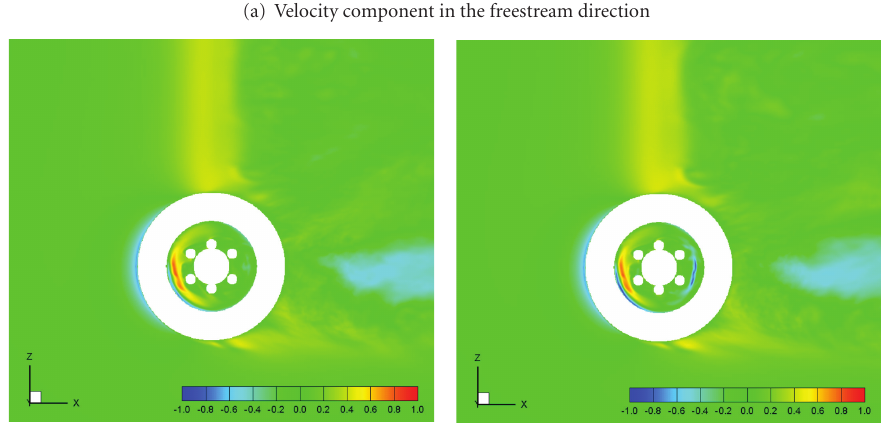
and NO TEAR are almost identical, whereas the values of NO TEAR are slightly lower. Large di ff erence is observed for FRONT TEAR geometry as the higher value’s region is shifted and the values get weaker. The di ff erence is caused by the torque link position to be attached at the